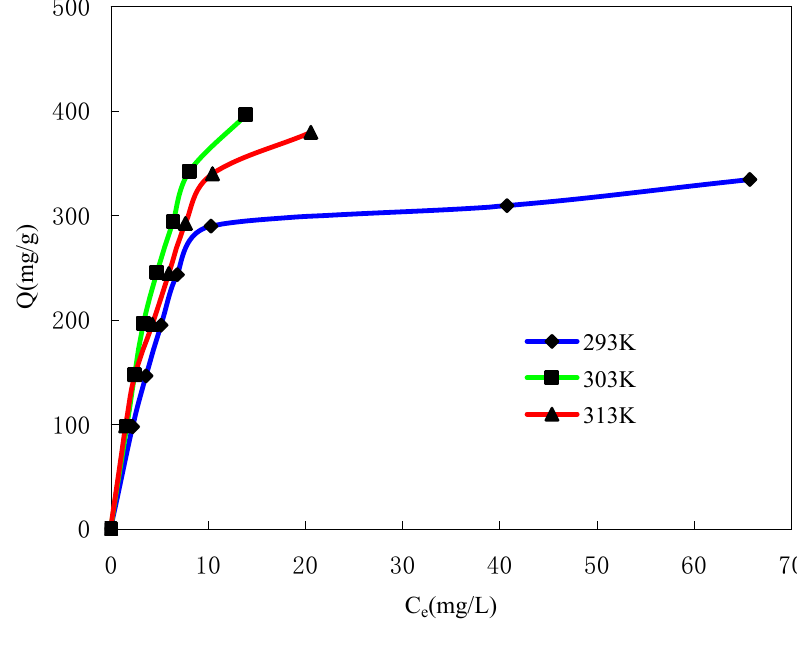
Figure 4. Effect of initial MB concentration on MB adsorption by ASMs. t = 2 h.